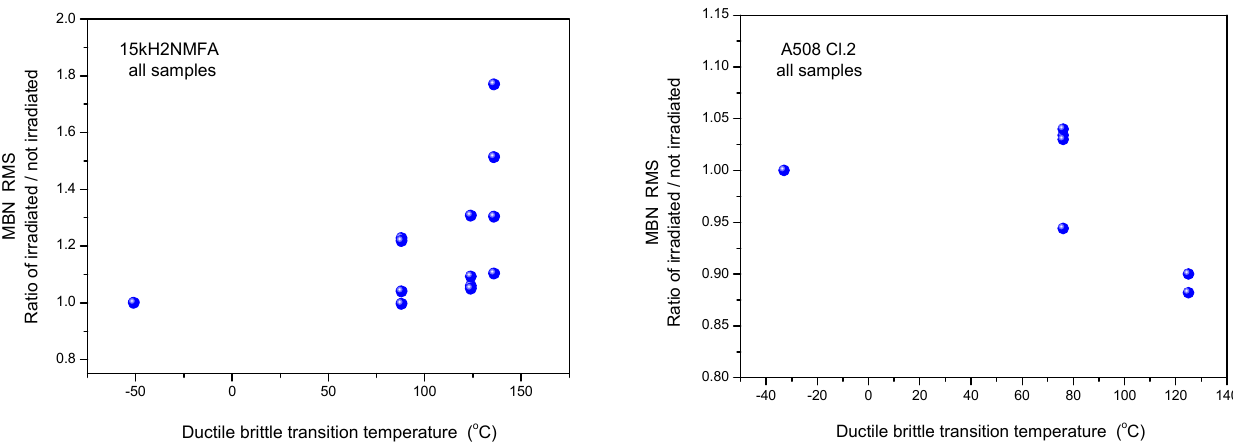
Figure 8. Normalized MBN RMS parameter as function of transition temperature for all 15kH2NMFA and A508Cl.2 samples.